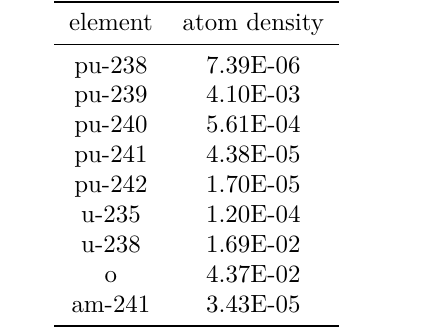
Table 1. Fresh MOX material composition.